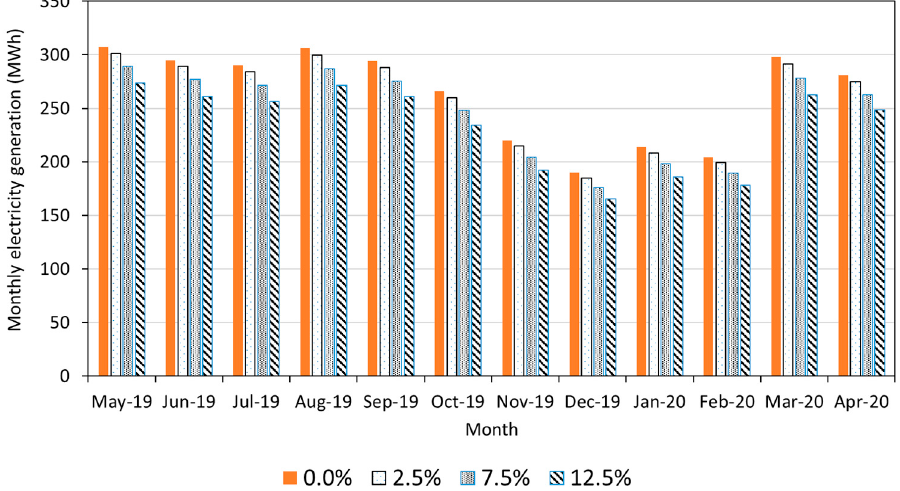
Figure 11. Effect of the soiling percentage on the monthly electricity generation.